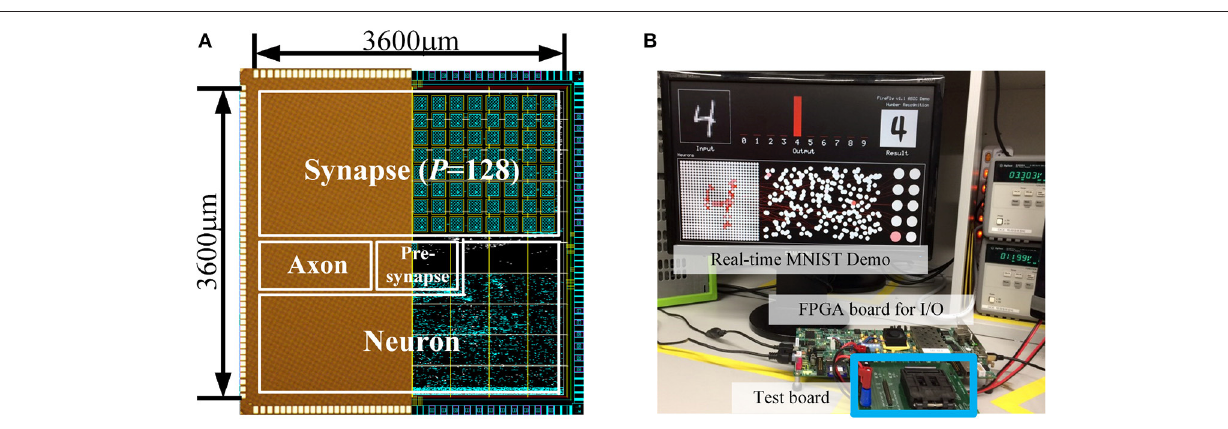
FIGURE 14 | (A) Die microphotograph and layout of the design (65 nm CMOS) and (B) Demo & measurement